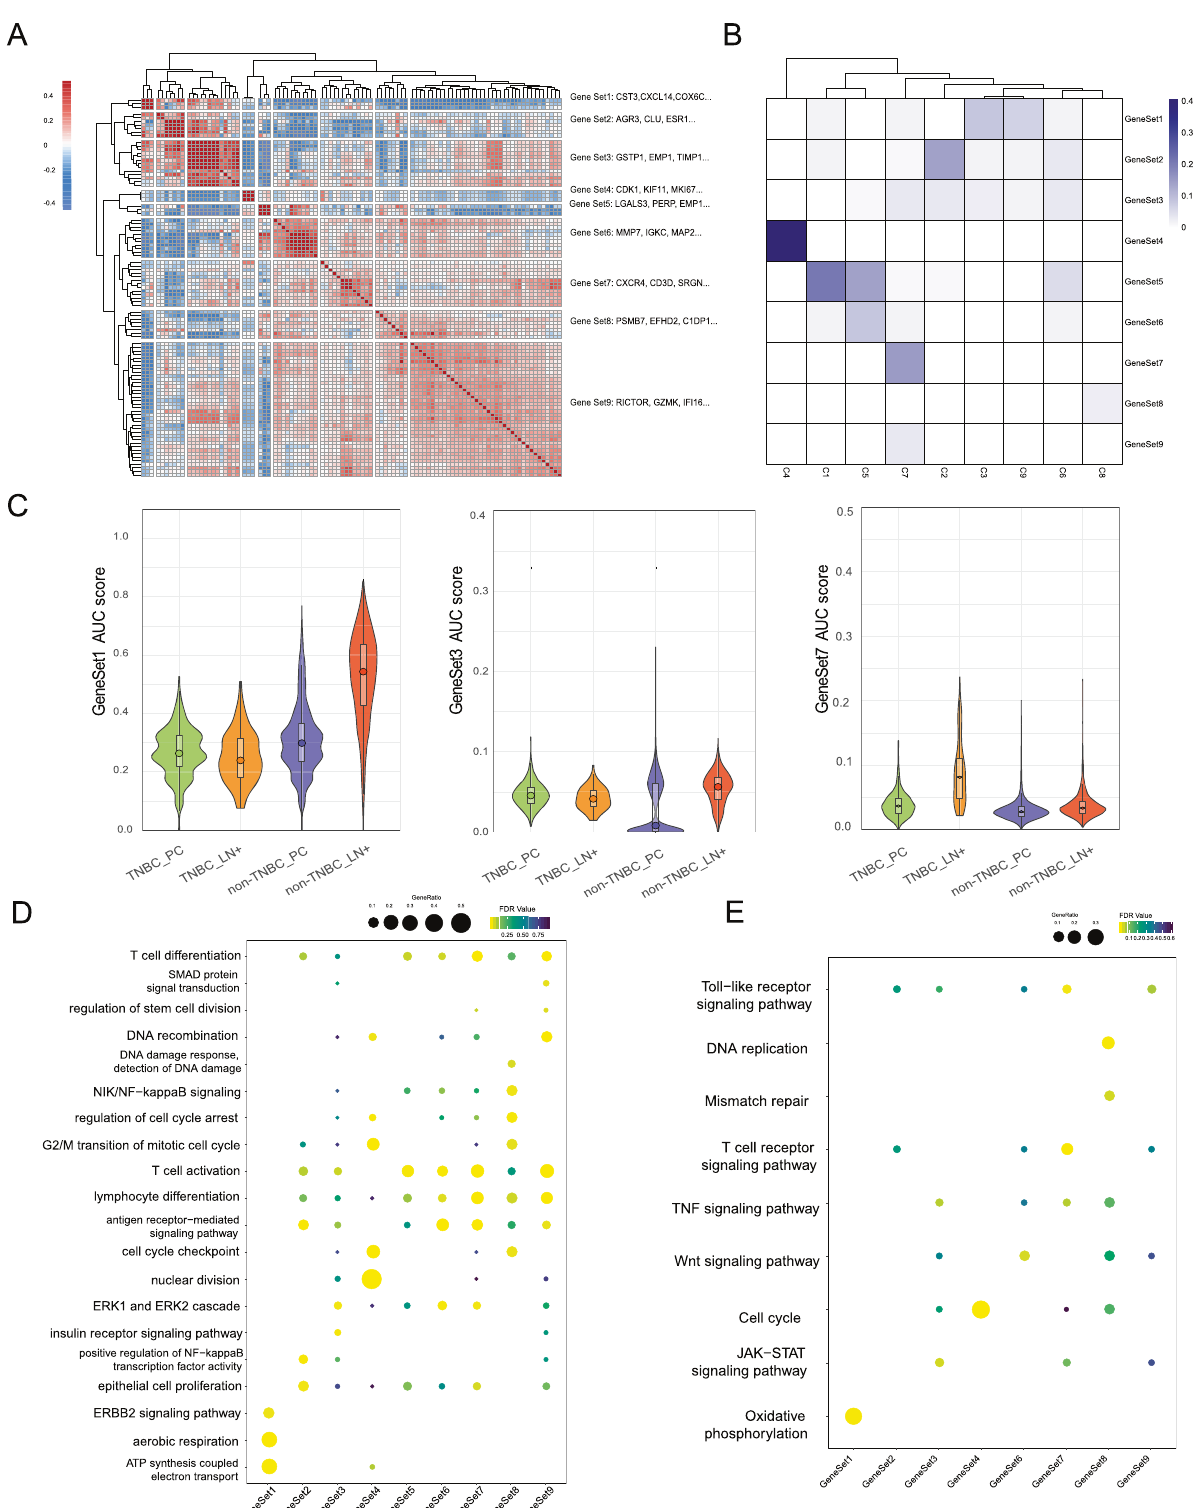
Fig. 4 Integrated analysis based on malignant cell identity. A Heatmap showing correlation of all programs derived from cNMF analysis of individual patients with breast cancer. Nine highly correlated meta-programs are highlighted. B Jaccard similarities of nine meta-programs (y- axis) with the signatures of nine cancer cell types ( x -axis). C Violin plots showing the score of different sample origins in meta-program 1, 3, and 7. D, E GO ( D ) and KEGG ( E ) analysis of cancer cell